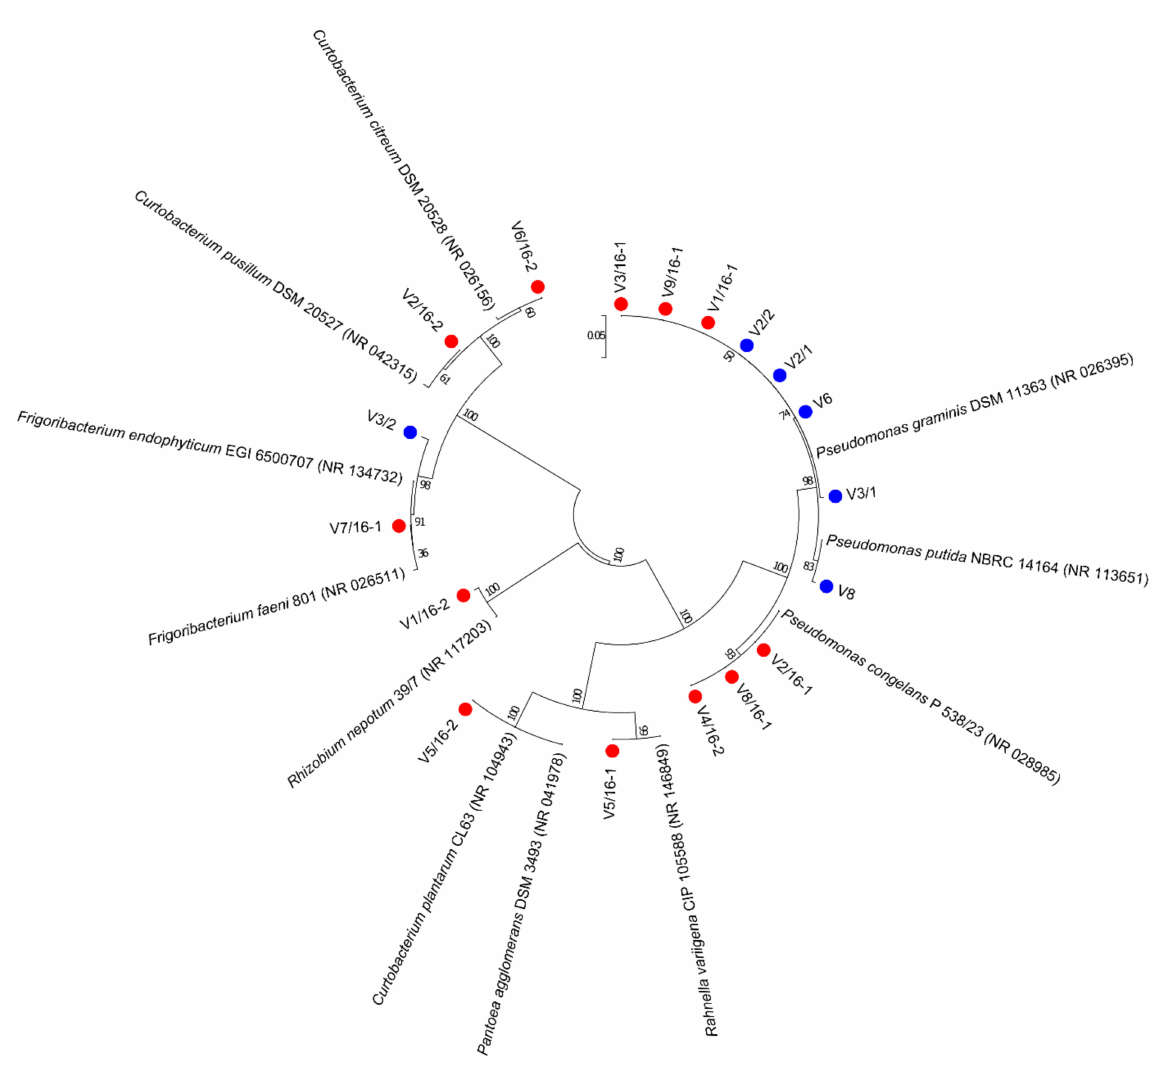
Figure 1. Phylogenetic relationships of bacterial isolates from ‘Williams’ pear variety in two phe- nological stages (May • and July • ) based on the 16S rRNA sequence. A phylogenetic tree was constructed by the Neighbor-joining method and the distances were calculated with the Kimura two-parameter model. Bootstrap values are given for each node, with 1000